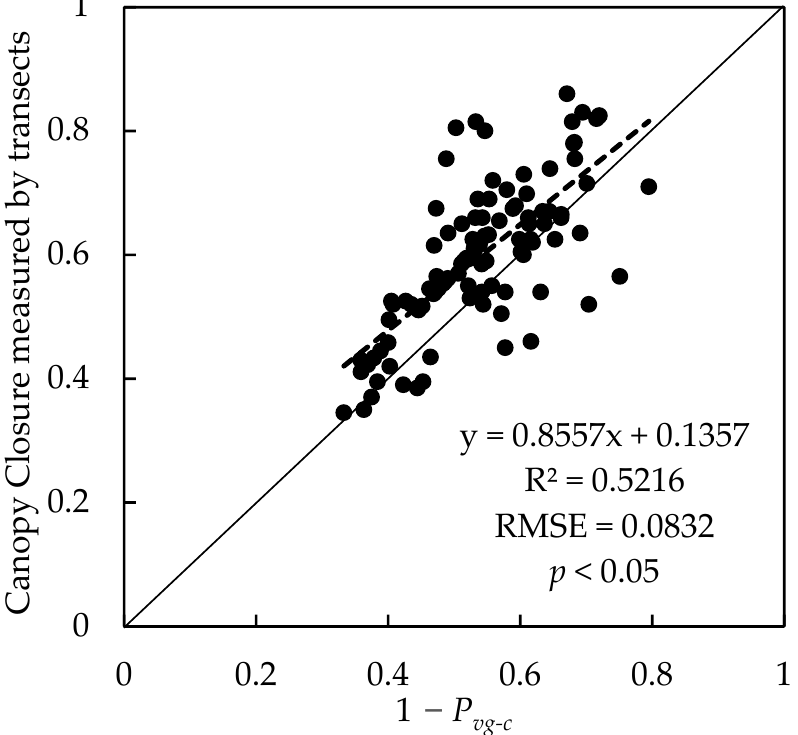
Figure 8. Scattering plot between the measured canopy closure and 1 − P vg-c (the black solid line is y = x ).